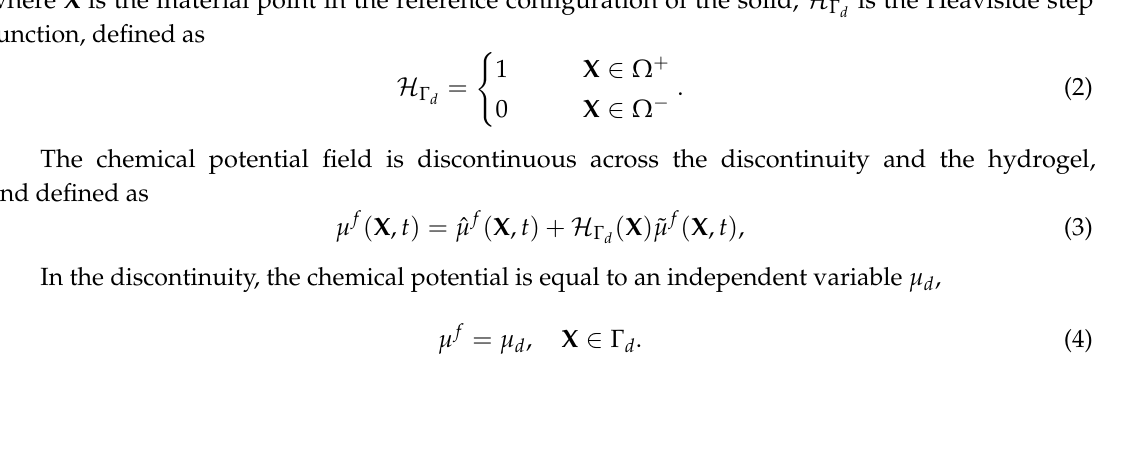
Figure 9. The body Ω is crossed by a discontinuity (dashed line). n Γ discontinuity surface pointing to Ω +